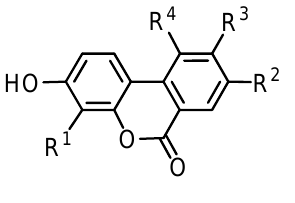
Figure 8. Metabolites of geraniin.